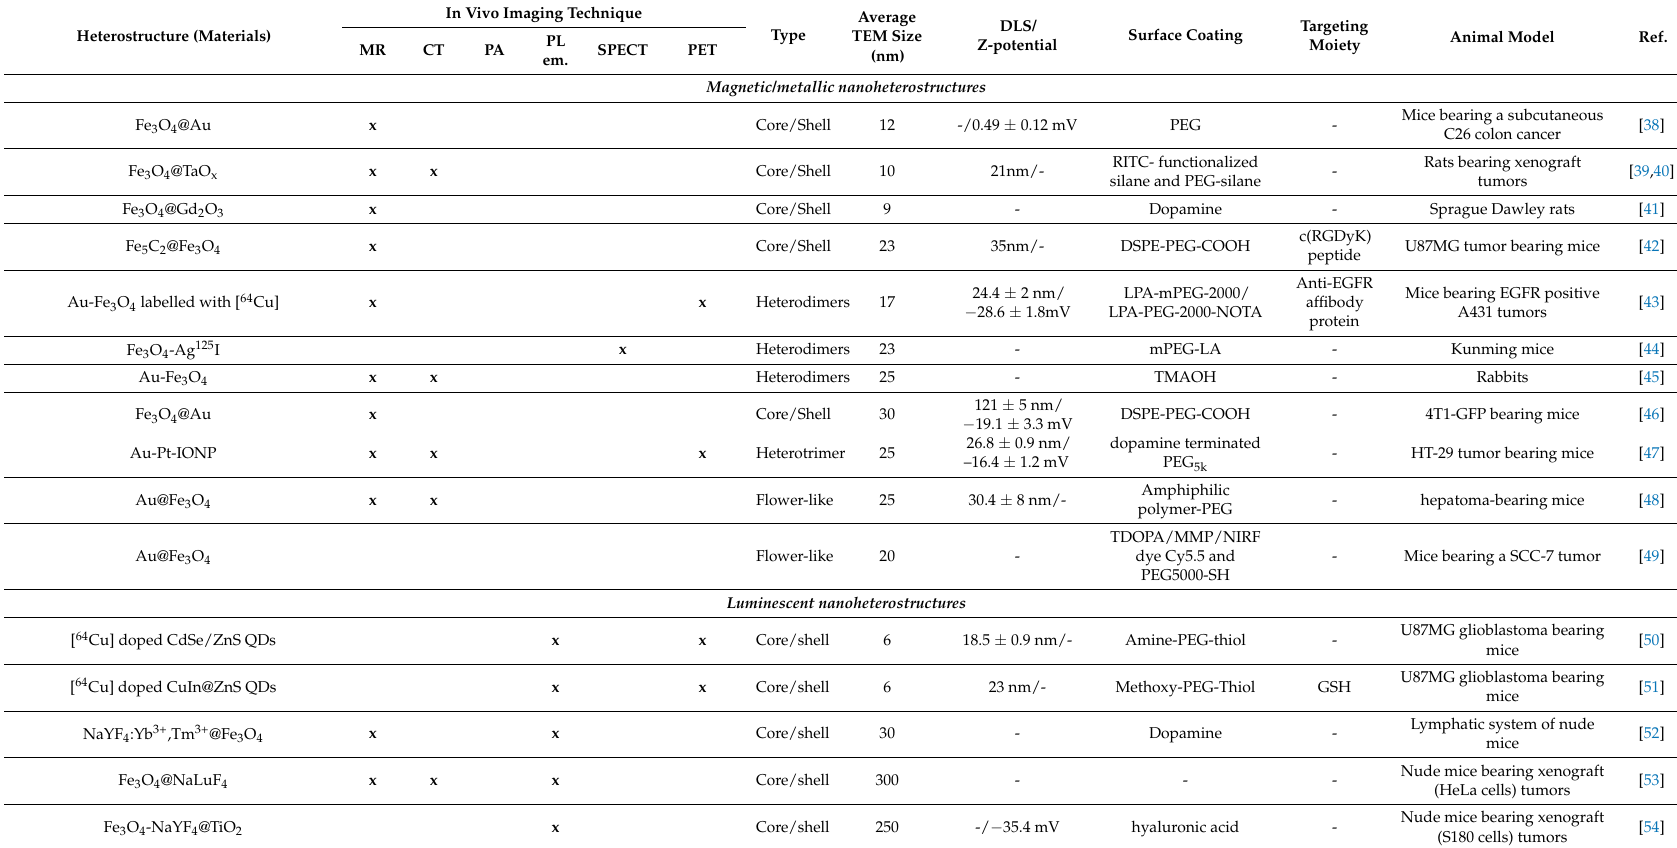
Table 1. Summary of nanoheterostructures applied in